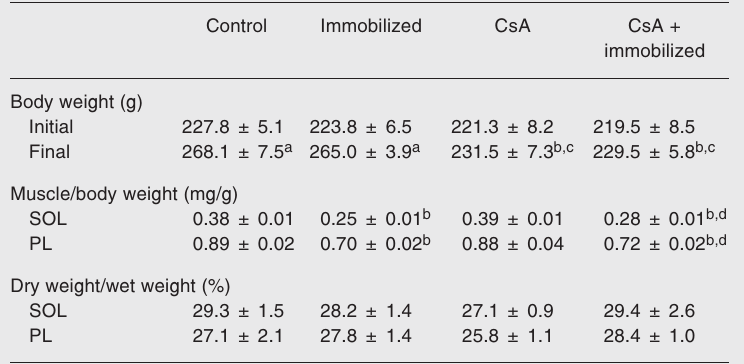
Table 1. Effect of cyclosporin-A (CsA) administration on rat soleus (SOL) and plantaris (PL) muscles during